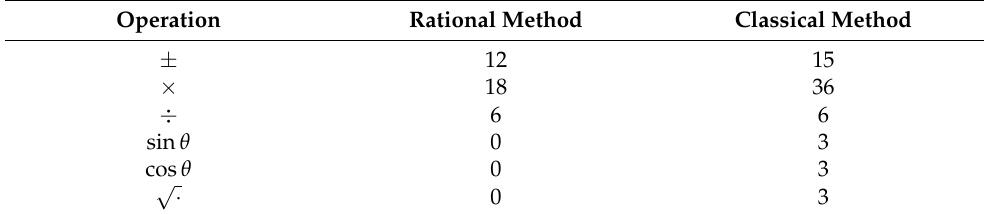
Table 4. Total number of operations for orientation